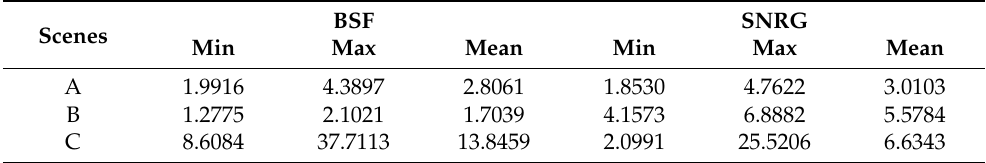
Table 4. The SNRG and BSF values of SPB